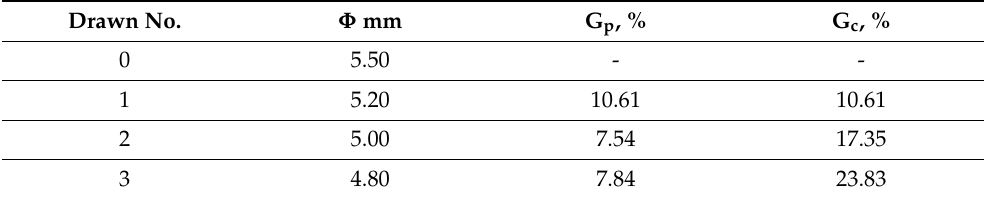
Figure 1. Schematic diagram of research. The process of drawing a 5.50 mm TRIP steel wire rod on semi-finished product wires with diameters of 5.00 and 4.80 mm was carried out in industrial conditions on the BS700 DRAWING machine. In the process, cone pullers made of sintered carbides with a drawing angle of 2 α = 12 ◦ were used. The drawing process was carried out at a drawing speed of 6.0 m/s. Table 2 shows the diagram of the single and total crushes used. Table 2. Diagram of the single (G p ) and total reduction (G c ) used in the drawing process of a wire rod with a ferritic–perlitic structure and a diameter of 5.50 mm for a wire with semi-finished product diameters of 5.00 and 4.80 mm.